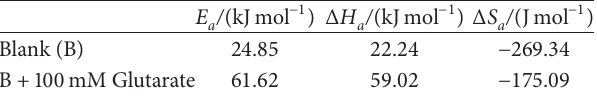
Table 5: Activation parameters for carbon steel in 0.02 M NaCl solution in the absence and in the presence of 100mM sodium